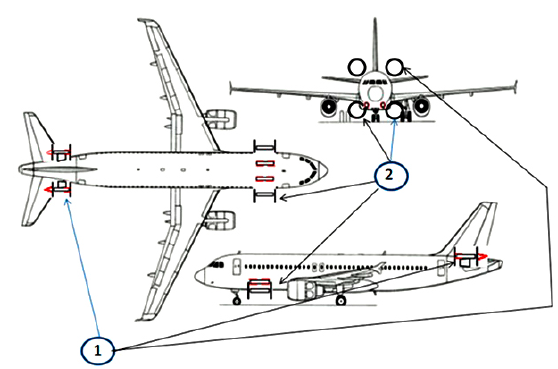
Fig. 10. Two solutions of the hybrid propulsion system